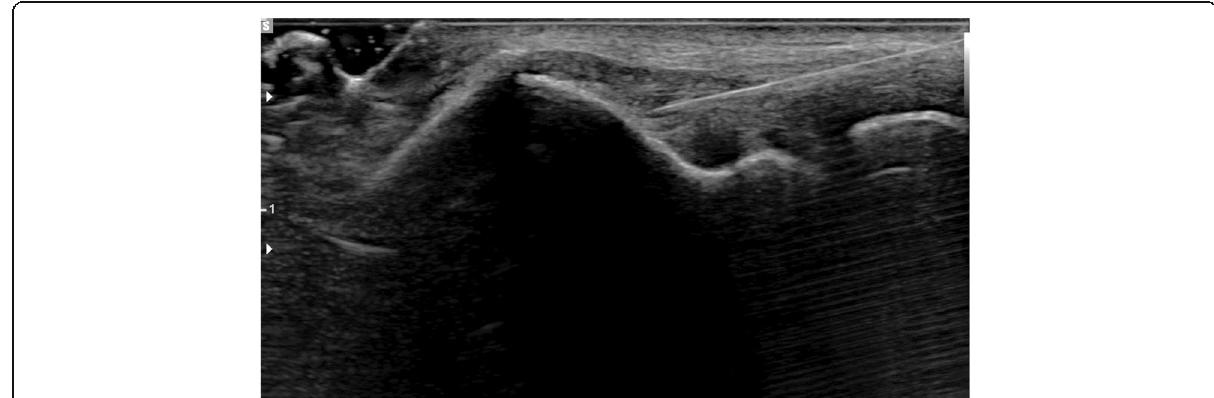
Fig. 1 Longitudinal ultrasonogram of the Common Extensor Tendon (CET). The hypodermic needle can been seen entering at the right side of the image. This particular specimin underwent a 1 ml single shot injection